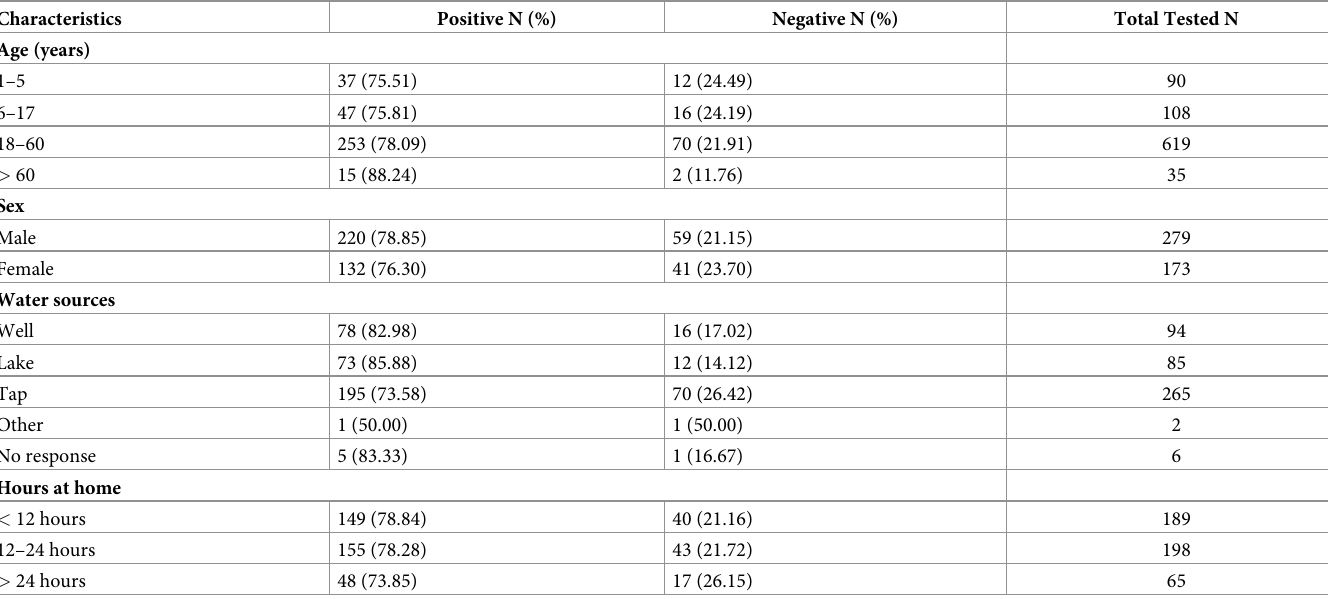
Table 2. Laboratory test results for cholera of those tested at the camps.